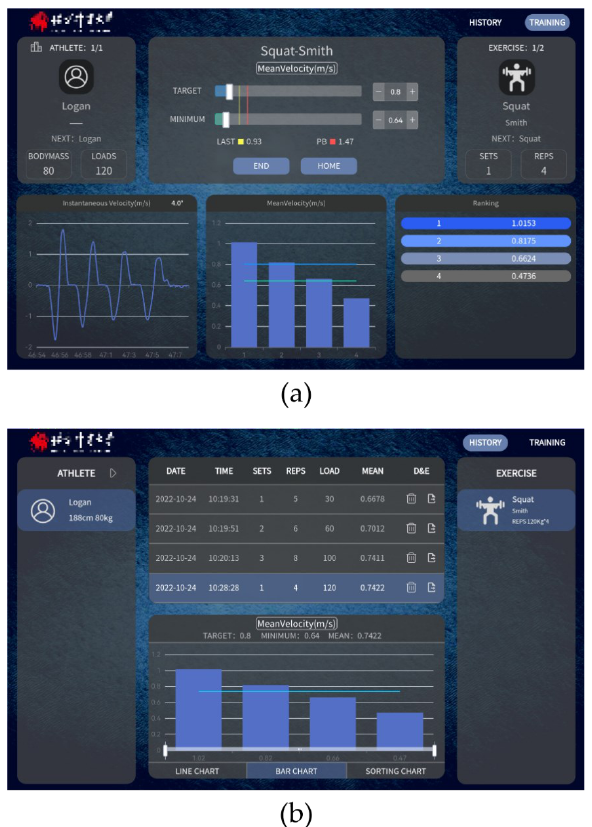
Figure 5. Visualization interface of the software: ( a ) training data interface; ( b ) history data interface.